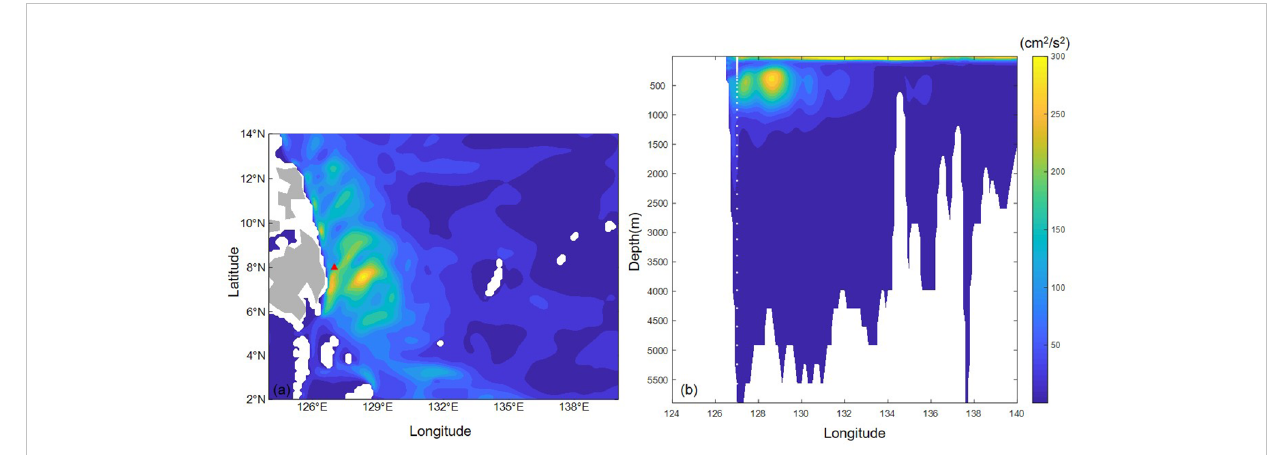
FIGURE 10 Mean EKE at 605 m (A) and along 8°N (B) during September 2014 to February 2016 derived from the OFES outputs.